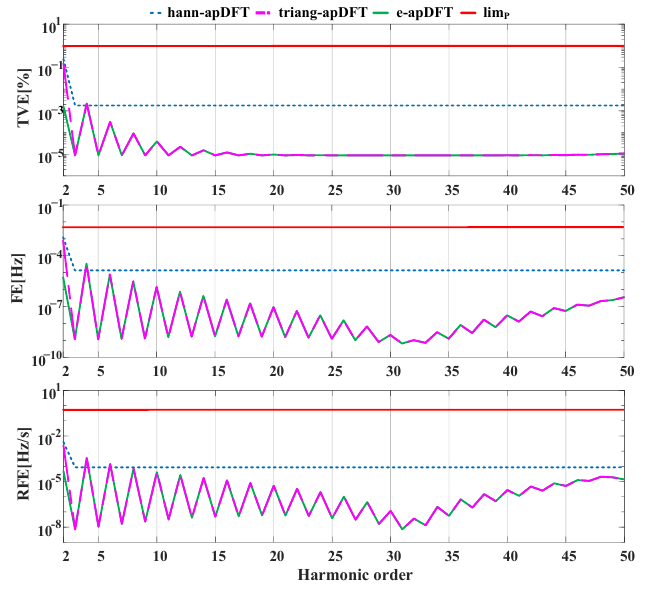
Figure 7. Harmonic distortion test (THD = 1%).